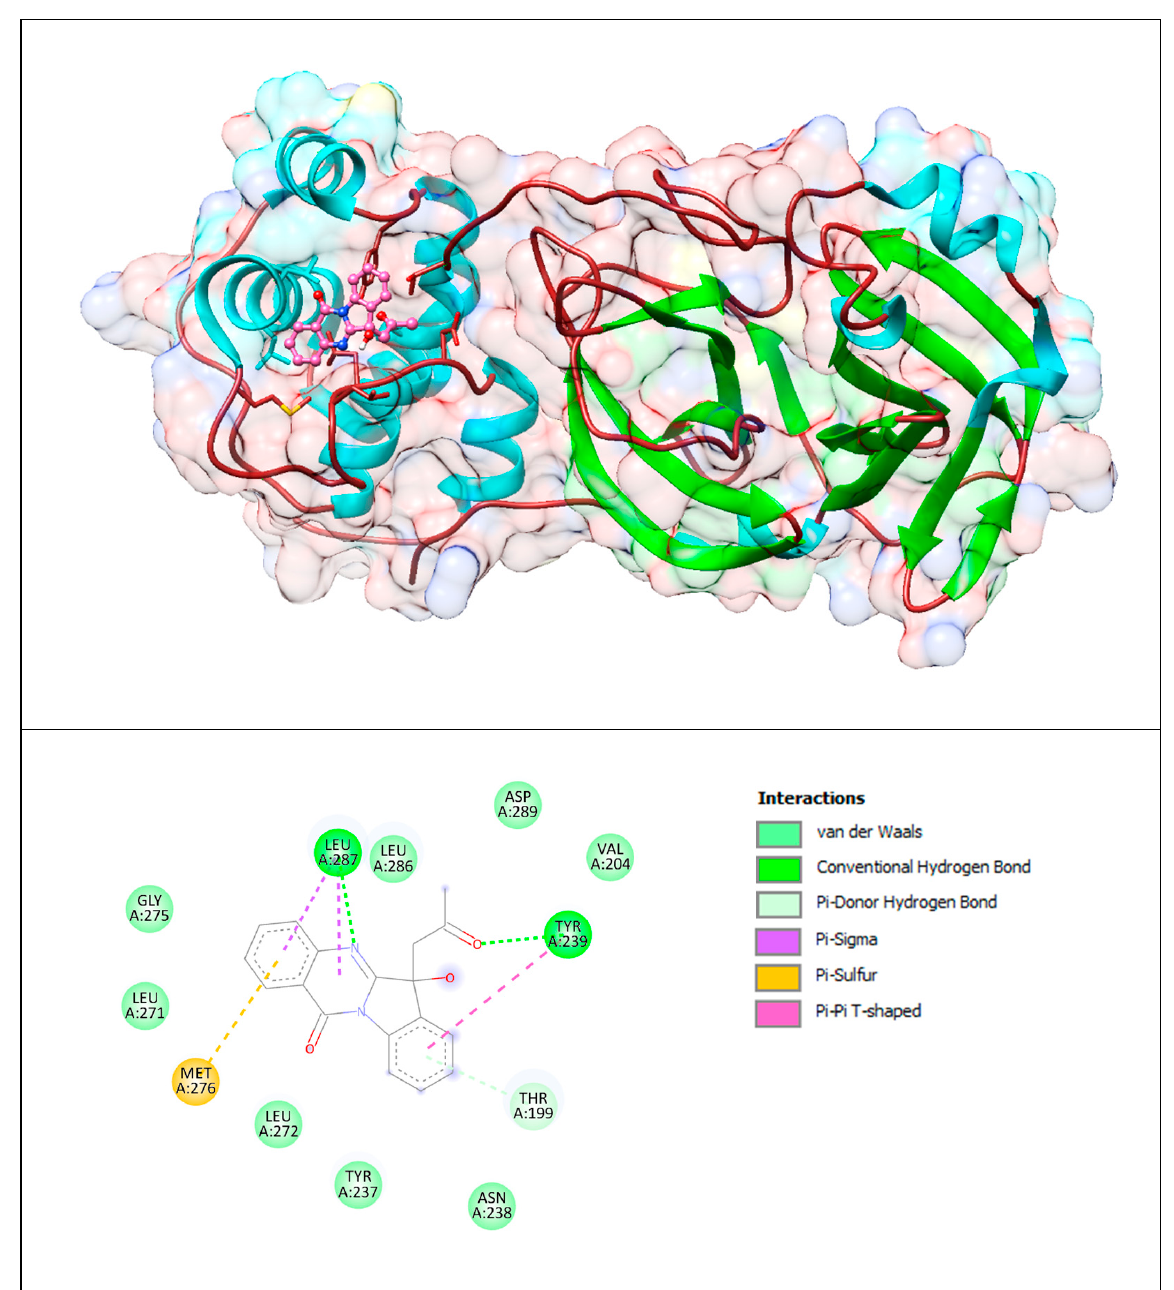
Figure 15. Mpro with PAA. The upper panel shows a 3D model of Mpro with a binding site (cavity) on its surface PAA. The lower panel shows the binding mode of the PAA compound with the amino acid residues of Mpro. Figure was created with UCSF Chimera ( upper panel ) and BIOVIA Discovery Studio Visualiser ( lower panel ) and shows the best docking pose of PAA on Mpro. We can also see where PAA is placed on the Mpro surface and a general view of the complex of Mpro (green– cyan–brown) with PAA (pink). The secondary structure of the protease behind the molecular surface (created with 90% transparency to better illustrate the molecule) is also shown. Other aa (ASP289, LEU286, VAL204, GLY275, LEU271, LEU272, TYR237, ASN238) participate in vdW interactions with